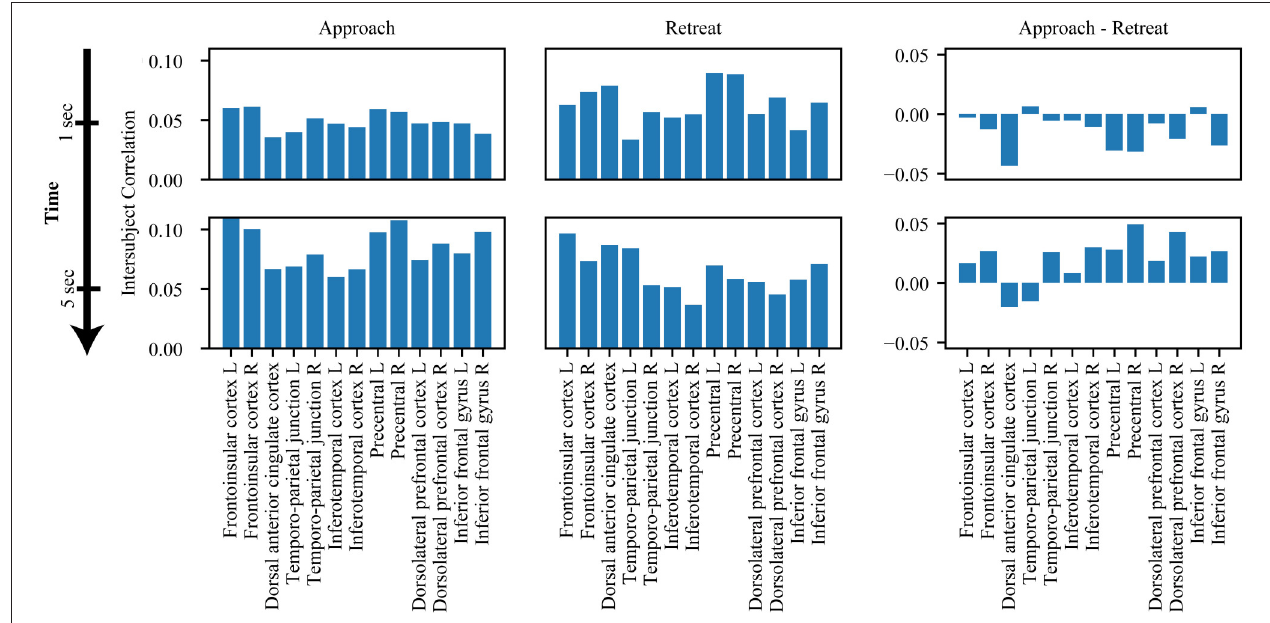
FIGURE 8 | Snapshots of intersubject correlations between right PAG and salience network. Results are shown for approach and retreat conditions, as well as approach minus retreat. The top row shows intersubject correlations at t = 1s, and the bottom row shows intersubject correlations at t = 5s. Intersubject correlations between the right PAG and the salience network increased during approach and decreased during retreat.